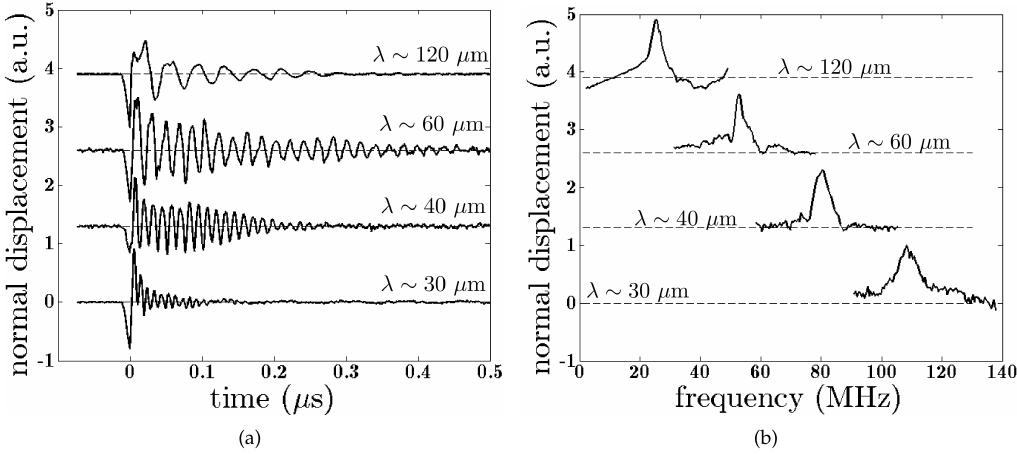
Figure 8. ( a ) Set of acoustic signals selected from Figure 7b with a relatively large wavenumber component. The extracted signals contain wavelength components corresponding to λ k = 120/k with k = 1,2, 3, . . . They were obtained after high-pass filtering the thermoelastic signal. ( b ) Corresponding spectra of ( a ), revealing spectral peaks corresponding with SAW components at different